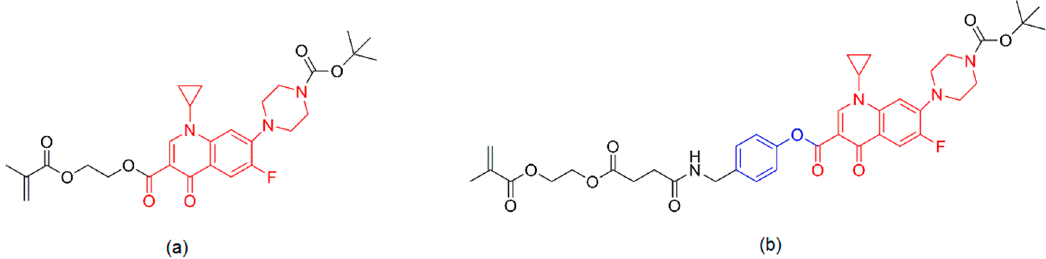
Figure 13. Structures of the prodrug methacrylated monomers: ( a ) prodrug with the aliphatic ester linkage; and ( b ) prodrug with the aromatic ester linkage. In red is represented the structure of ciprofloxacin.